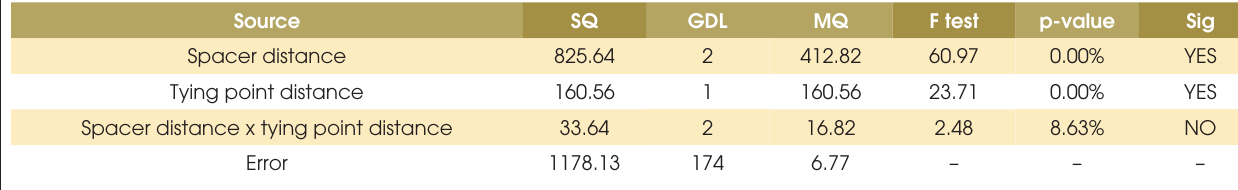
Table 3 – Analysis of variance (ANOVA) of controllable factors